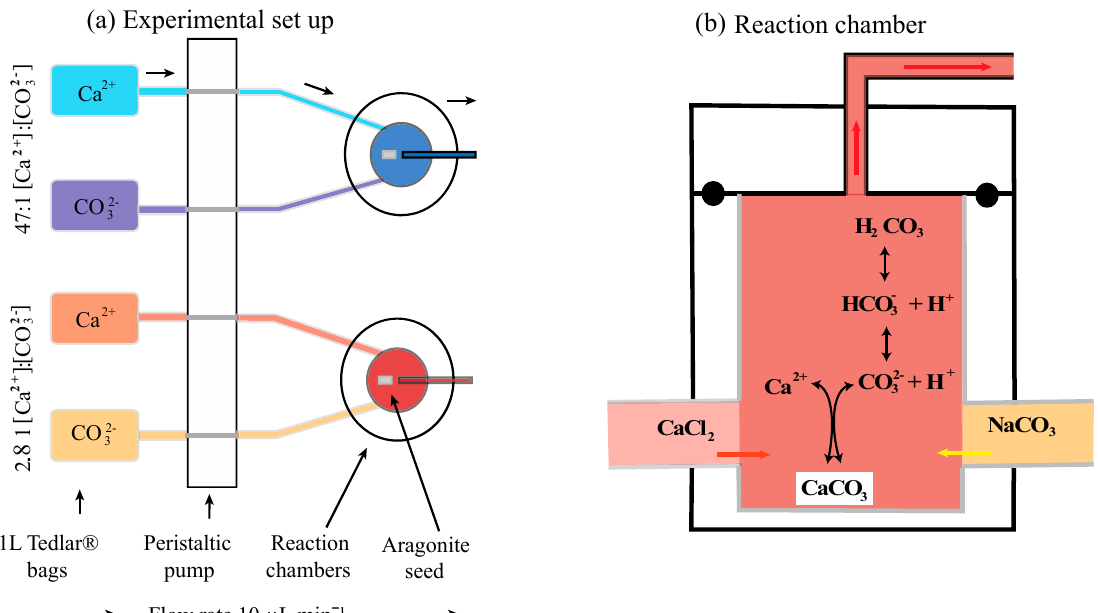
Figure 2. Schematic design of the experimental conditions showing ( a ) the separate stock solutions of Ca and CO 3 passing through the peristaltic pump and mixing in the reaction chambers, and ( b ) the physicochemical conversions of CaCO 3 , bicarbonate [HCO 3 − ] and CO 3 occurring during mineral precipitation and dissolution phases. Each of the six experimental scenarios is outlined in Table 1.